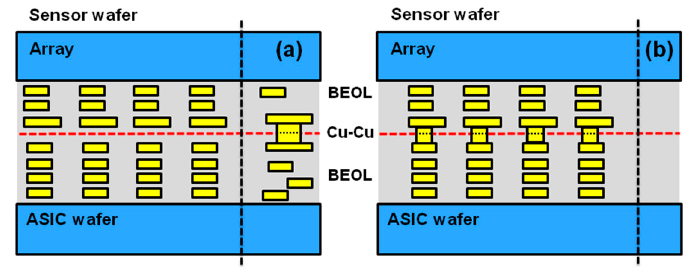
Figure 2. Hybrid bond-stacking schematic, showing the Cu-Cu interconnects outside the array ( a ) and within the array ( b ).